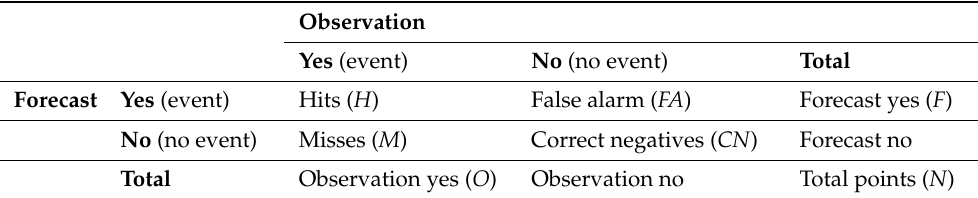
Table 2. The 2 × 2 contingency table for dichotomous (yes/no) forecasts of rainfall reaching a given threshold at a set of verification points ( N ). Observation Yes (event) No (no event) Total Forecast Yes